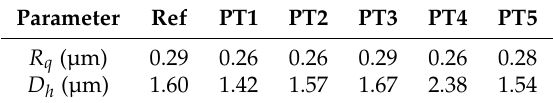
Table 3. Roughness R q and peak-to-valley distance D h of the investigated cold-rolled aluminium samples.